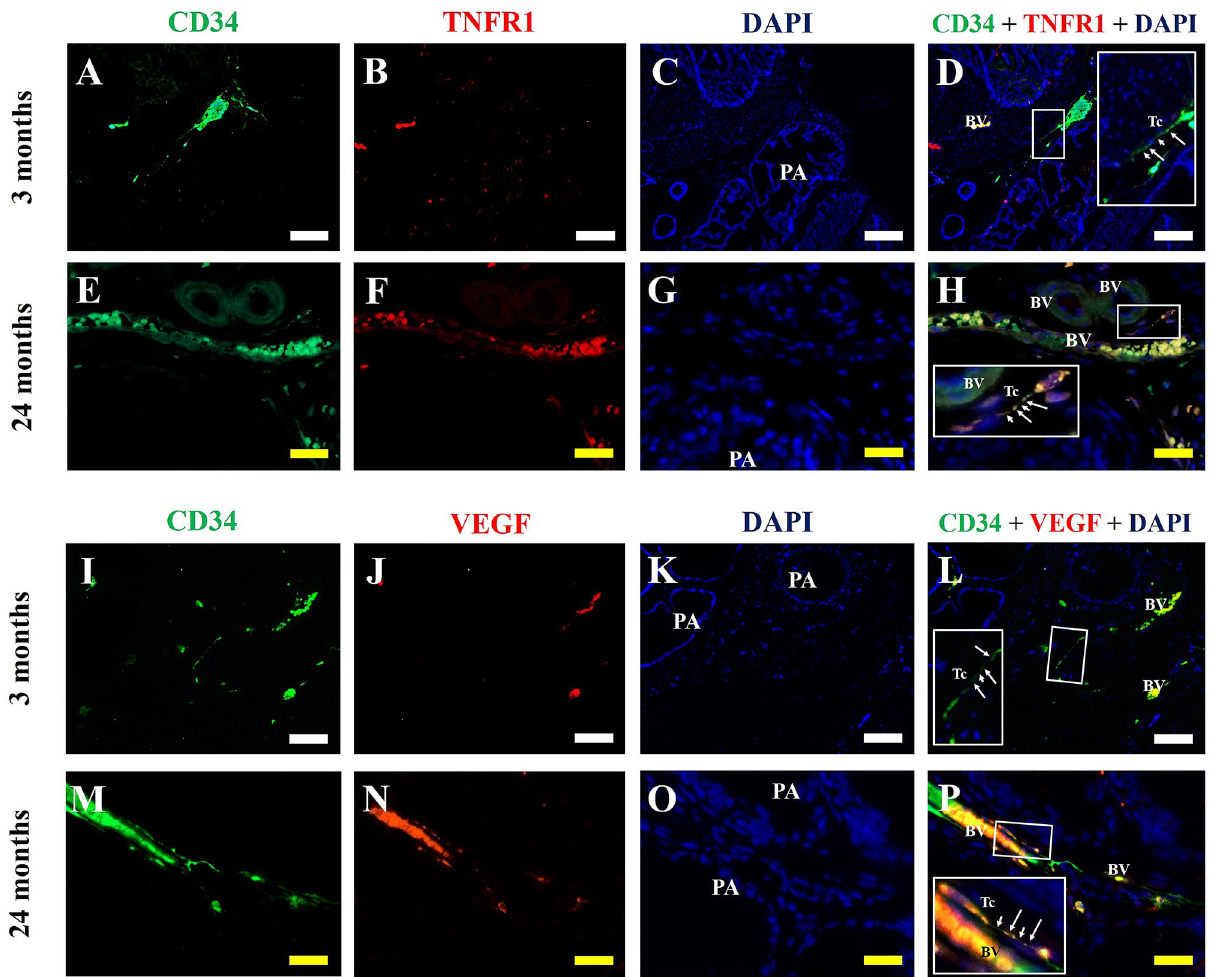
Figure 7. Double immunofluorescence assays for CD34 and TNFR1, as well as for CD34 and VEGF in prostate histological sections of the adult (3 months old) and senile (24 months old) male Mongolian gerbils. ( A – D ) In the adult prostate, TNFR1 does not colocalize in the telocytes. ( E – H ) In the senile prostate, it is possible to observe the TNFR1 immunolabeling in a telocyte. ( I – L ) The colocalization of VEGF immunolabeling with CD34 in the adult prostate can be seen in blood vessels, but not in telocytes. ( M – P ) In the senile prostate, it is possible to verify the colocalization between VEGF and CD34 in a telocyte. PA (Prostate alveoli), BV (Blood vessel), Tc (Telocyte), Insert (Detail of telocytes, in which the moniliform aspect of the telopodes can be observed), Arrow (Podoms), arrowhead (Podomers), White bar (100 µm), Yellow bar (50